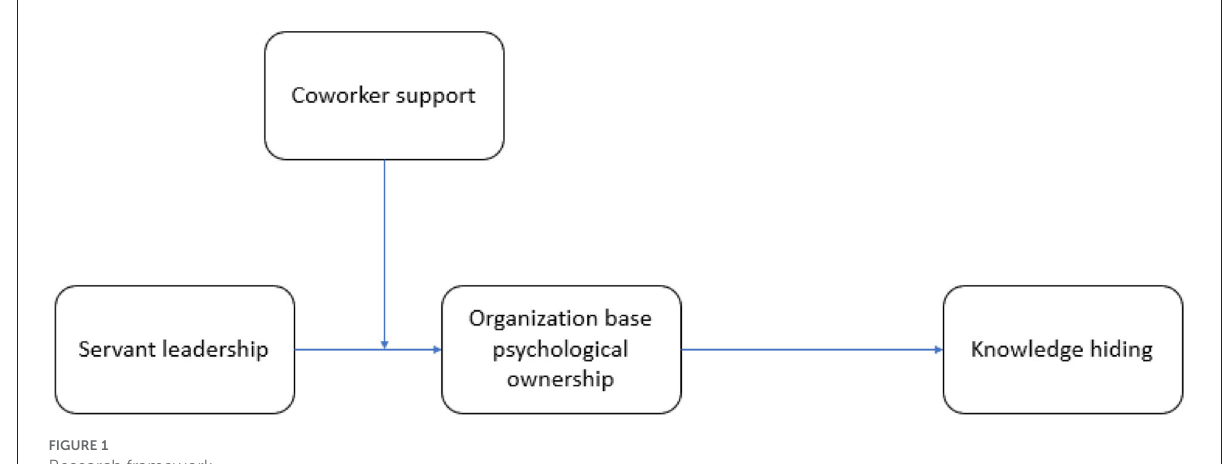
FIGURE1 Research